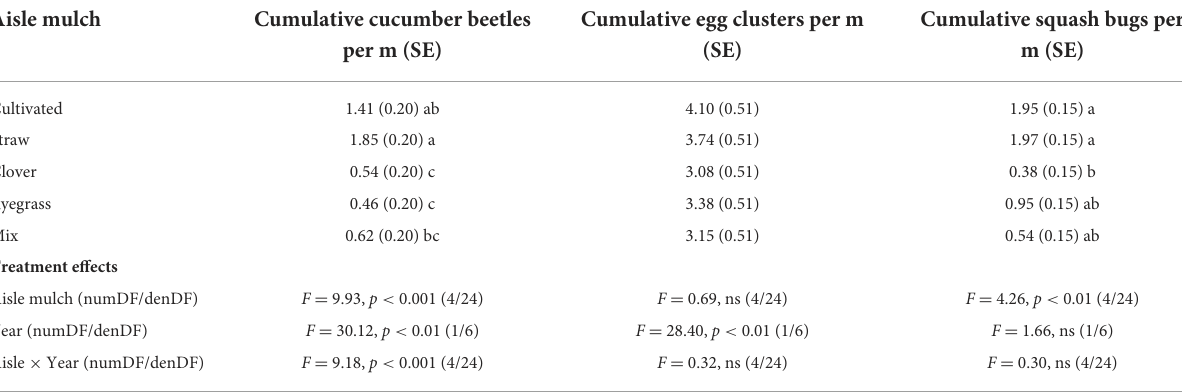
TABLE 4 Final cumulative counts of striped cucumber beetle, squash bugs and egg clusters in 2018 and 2019 on organic zucchini plants by living mulch treatment. Cumulative egg clusters per m Cumulative squash bugs Aisle mulch Cumulative cucumber beetles per m (SE) (SE)